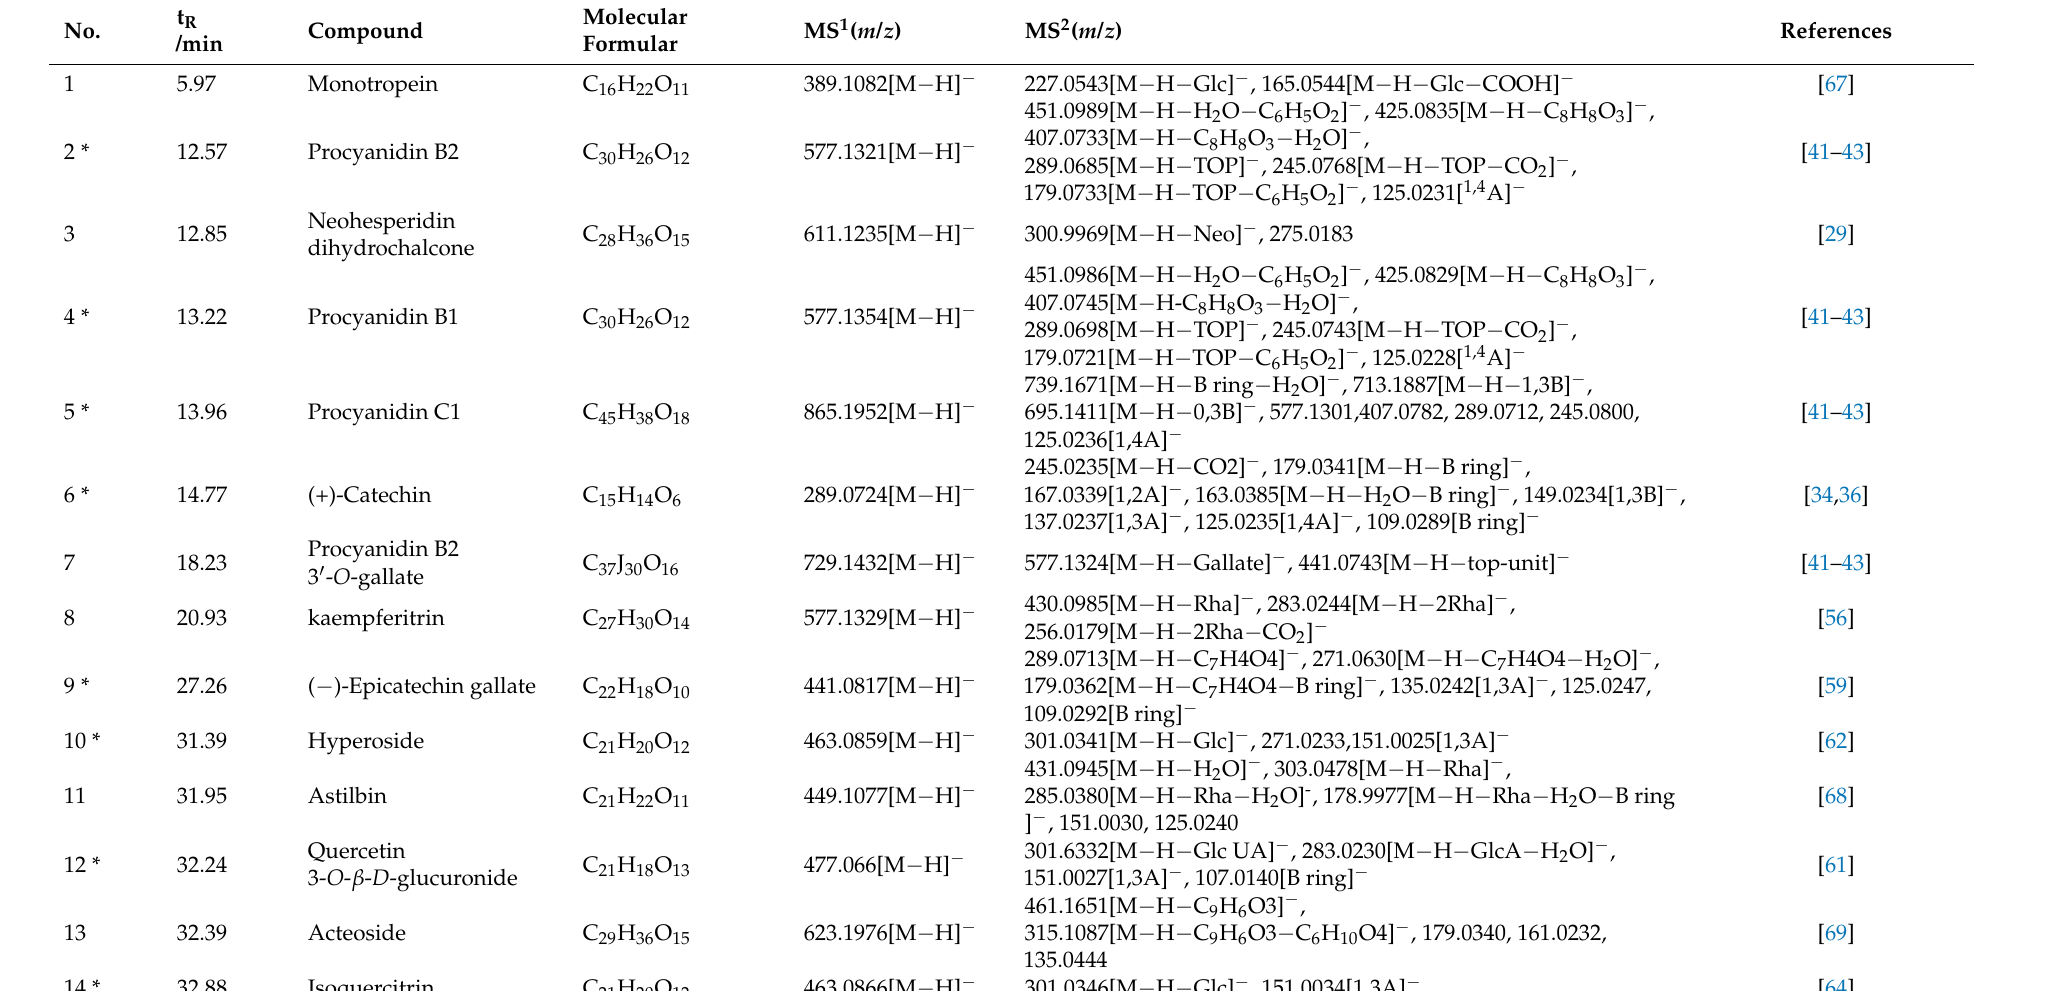
Table 2. Identification of the differential chemical